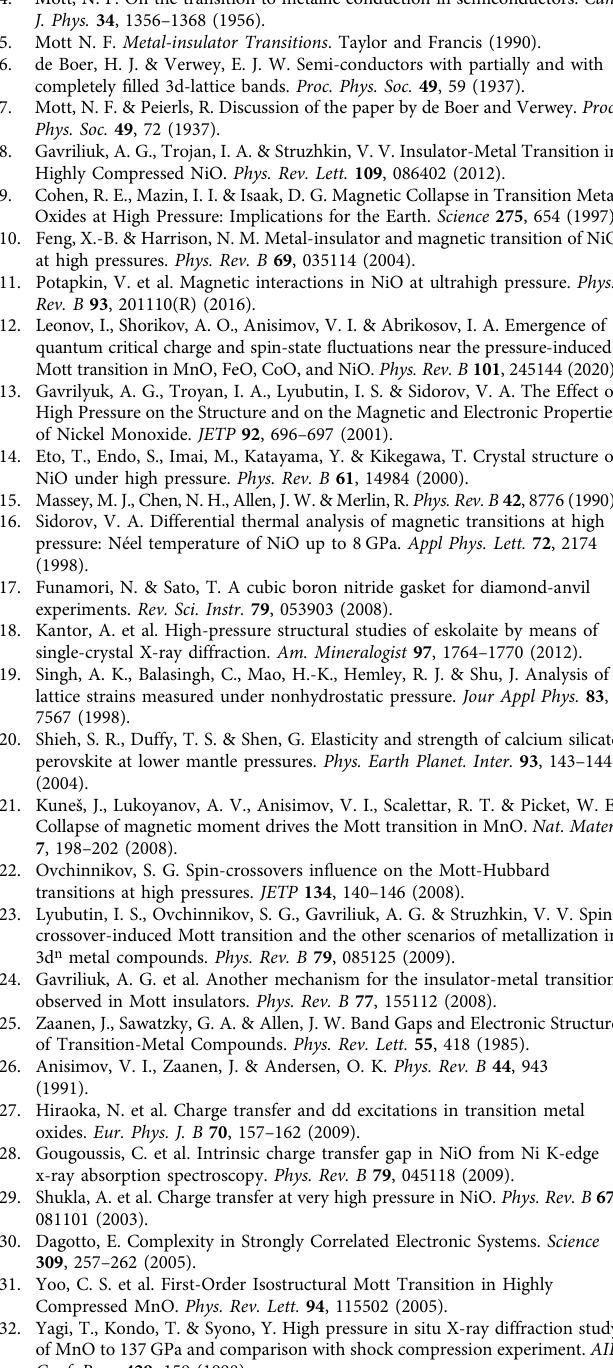
Table 2. Linear XRD scans through the NiO sample in run5 were made with 1 μ m step. The powder XRD images were integrated to one-dimensional patterns using the FIT2D 39 and DIOPTAS software 40 . The whole pro fi le analysis of the diffraction data and the calculation of the unit cell parameters were performed in JANA200 program 41 using the Le Bail method.